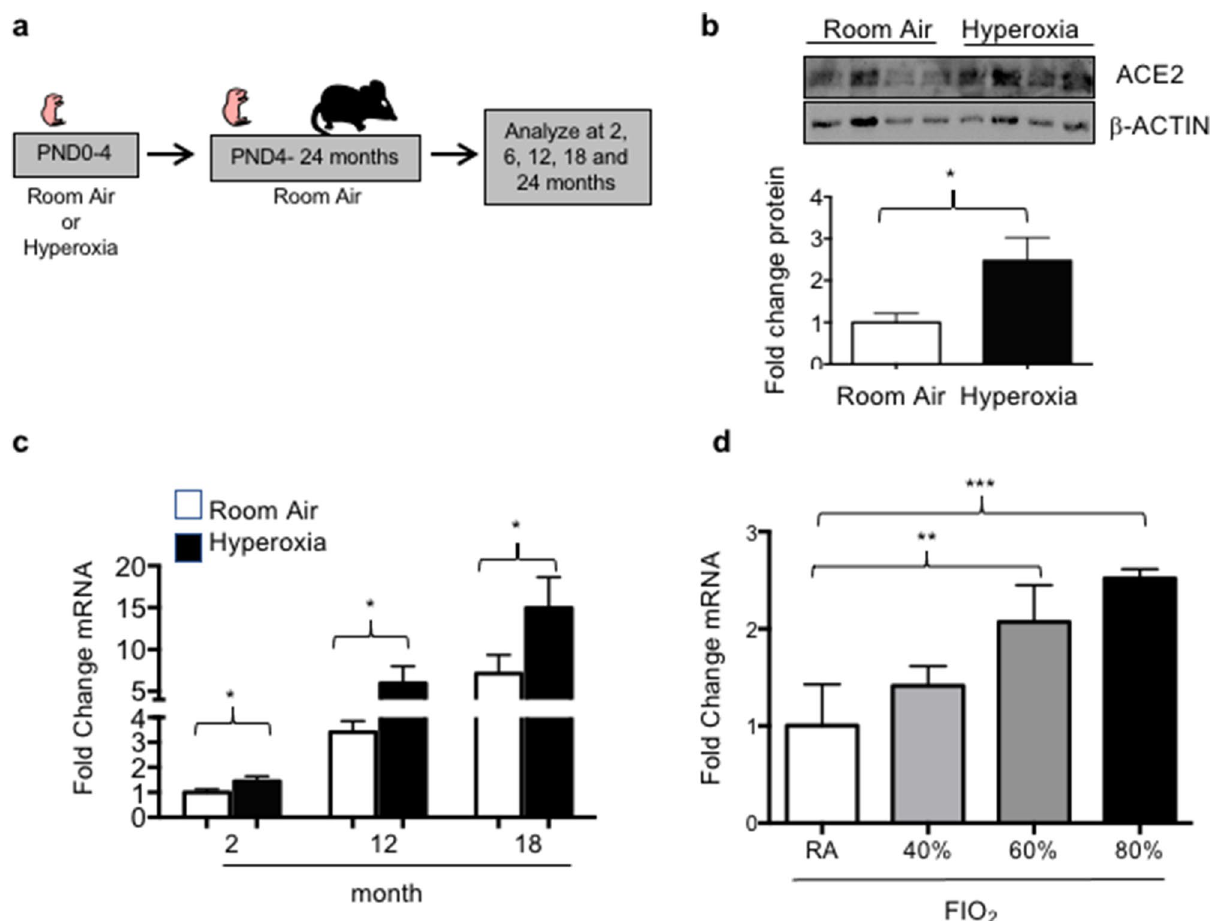
Figure 3. Neonatal hyperoxia stimulates expression of ACE2 in adult mice. ( a ) Cartoon showing the experimental approach of exposing newborn mice to hyperoxia. ( b ) Total lung homogenates were immunoblotted for ACE2 and β-ACTIN as a loading control. Data obtained from 5 mice per group is graphed as mean ± SD fold change over room air values. ( c ) qRT-PCR was used to quantify Ace2 mRNA in total lung homogenates of 2-, 12-, and 18-month-old mice exposed to room air or hyperoxia between PND0-4. Values were normalized to expression of 18S RNA and graphed as mean ± SD fold change of ACE2 in 2-month-old room air mice. N = 5 mice per group. ( d ) qRT-PCR was used to quantify Ace2 mRNA in total lung homogenates of 2-month-old mice exposed to room air, 40%, 60%, or 80% oxygen between PND0-4. Values were normalized to expression of 18S RNA and graphed as fold change of ACE2 in 2 month room air mice. N = 5 mice per group. Statistical significance for b-d is comparisons for all pairs using Tukey–Kramer HSD test with *P ≤ 0.05; **P ≤ 0.01; ***P ≤